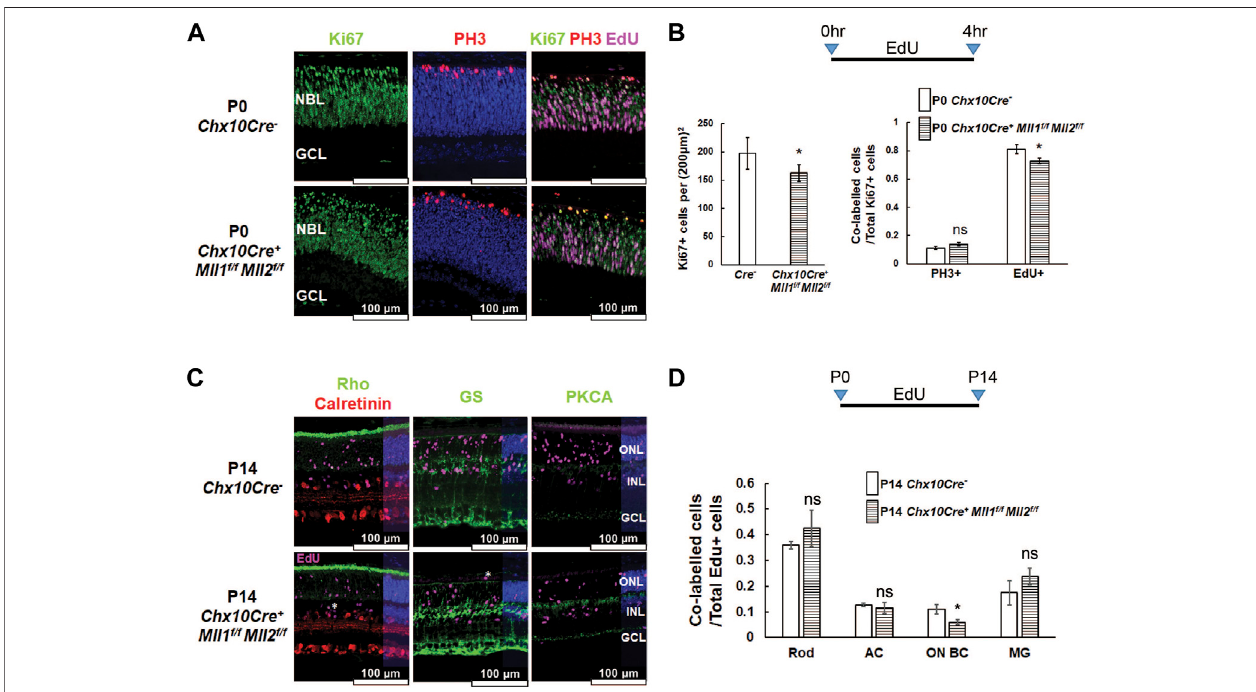
FIGURE 5 | Cell proliferation defects in Chx10Cre + Mll1 f/f Mll2 f/f . (A) Immunostaining of cell proliferation and cell cycle markers in the indicated P0 retinae: Ki67 (left panel,ingreen)forproliferatingcells,Ki67/PH3(centerpanel,Ki67ingreen,PH3inred)forcellsintheMphase,Ki67/EdU(rightpanel,Ki67ingreen,EdUinmagenta)for cells in the S phase. Nuclei (center panel) are DAPI counterstained in blue. Scale bar = 100 µm for all image panels. (B) Cell counts for Ki67 + proliferating cells in P0 Chx10Cre + Mll1 f/f Mll2 f/f and Chx10Cre - retinae (left panel), and cell counts of Ki67 + PH3+ and Ki67 + EdU + cells normalized to Ki67 + cells of each genotype. Error bars represent mean(SD) ( n =3). Ki67+ =Ki67 labeled cells, Ki67 +PH3+ =Ki67 and PH3 co-labeledcells, Ki67 +EdU+ =Ki67 and EdU co-labeledcells. (C) P14 retinal immunostaining of Rho/Calretinin/EdU (left panel, Rho in green, Calretinin in red, EdU in magenta), GS/EdU (center panel, GS in green, EdU in magenta), PKCA/ EdU (right panel, PKCA in green, EdU in magenta). White asterisks indicate mislocalized cells. (D) Cell compositions of co-labelled cells in P14 retinae of the indicated genotypes. Error bars represent mean (SD) ( n = 3). Results of statistical analysis are shown. Asterisks (*) denote p ≤ 0.05, ns means not signi fi cant by t -test. Rod = rod photoreceptors, AC = amacrine cells, ON BC = ON bipolar cells, MG = Müller glia.